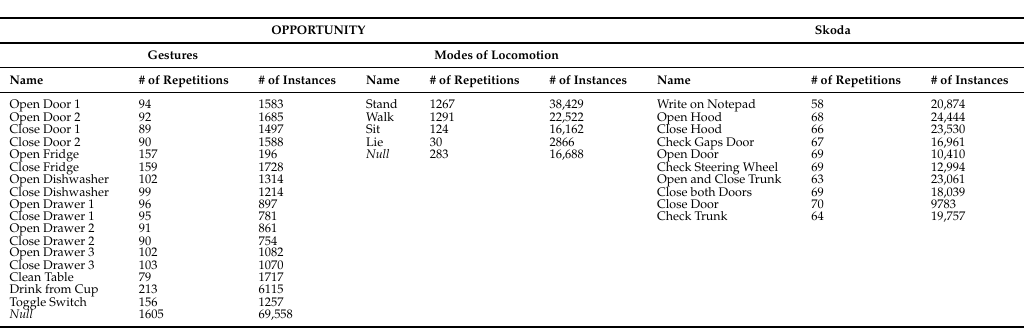
Table 2. Class labels for the OPPORTUNITY and Skoda datasets. The OPPORTUNITY dataset is divided into activities belonging to Task A (modes of locomotion) and Task B (gesture recognition). For each class, we report the number of times an activity is performed and the number of instances obtained by the sliding window (all subjects combined). The Null class corresponds to the time intervals where there are no activities of